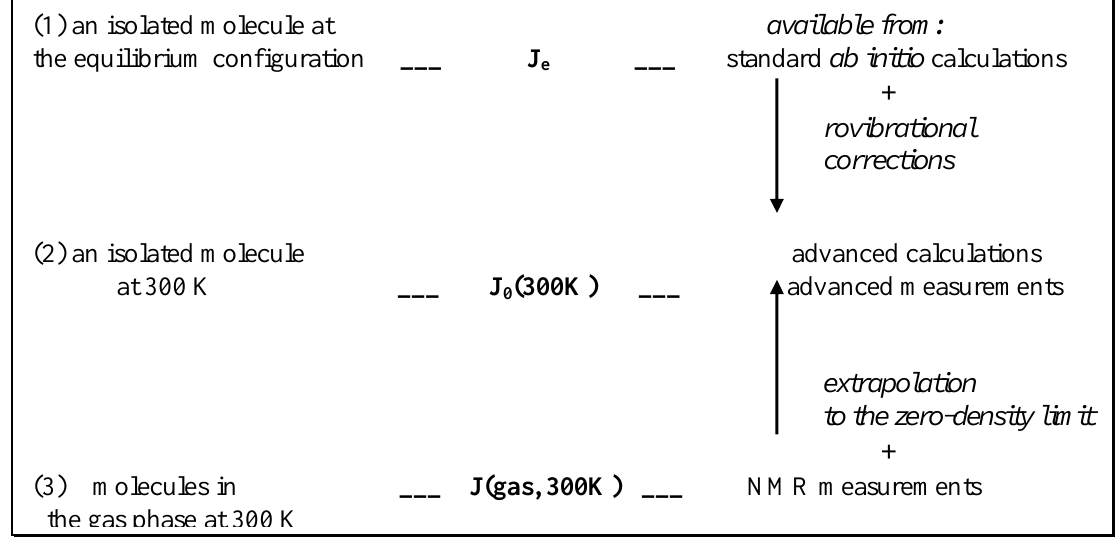
Figure 1. Modifications of spin-spin coupling constants due to internal rovibrational motion of a molecule (1) → (2) and molecular interactions (2) →